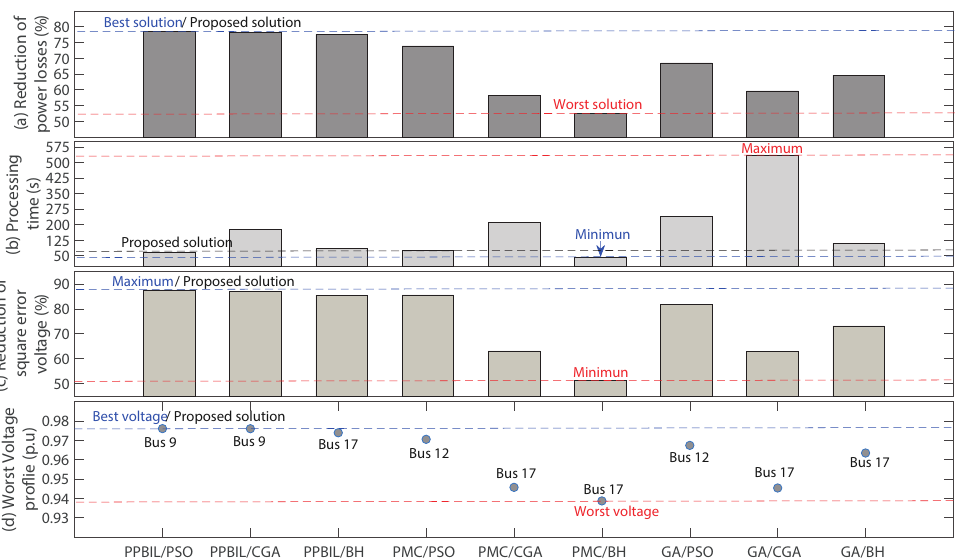
Figure 9. Results obtained with the 21 bus test system. ( a ) Reduction of power losses (%); ( b ) Processing Time (s); ( c ) Reduction of square error voltage (%); ( d ) Worst Voltage profile